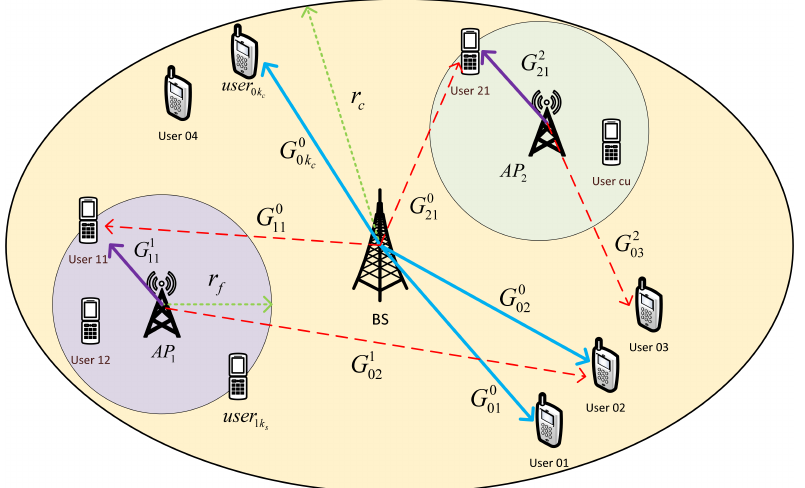
Figure 1. HetNet model for the downlink scenario. The lines with arrows denote the wireless links: direct link (solid), interfering link